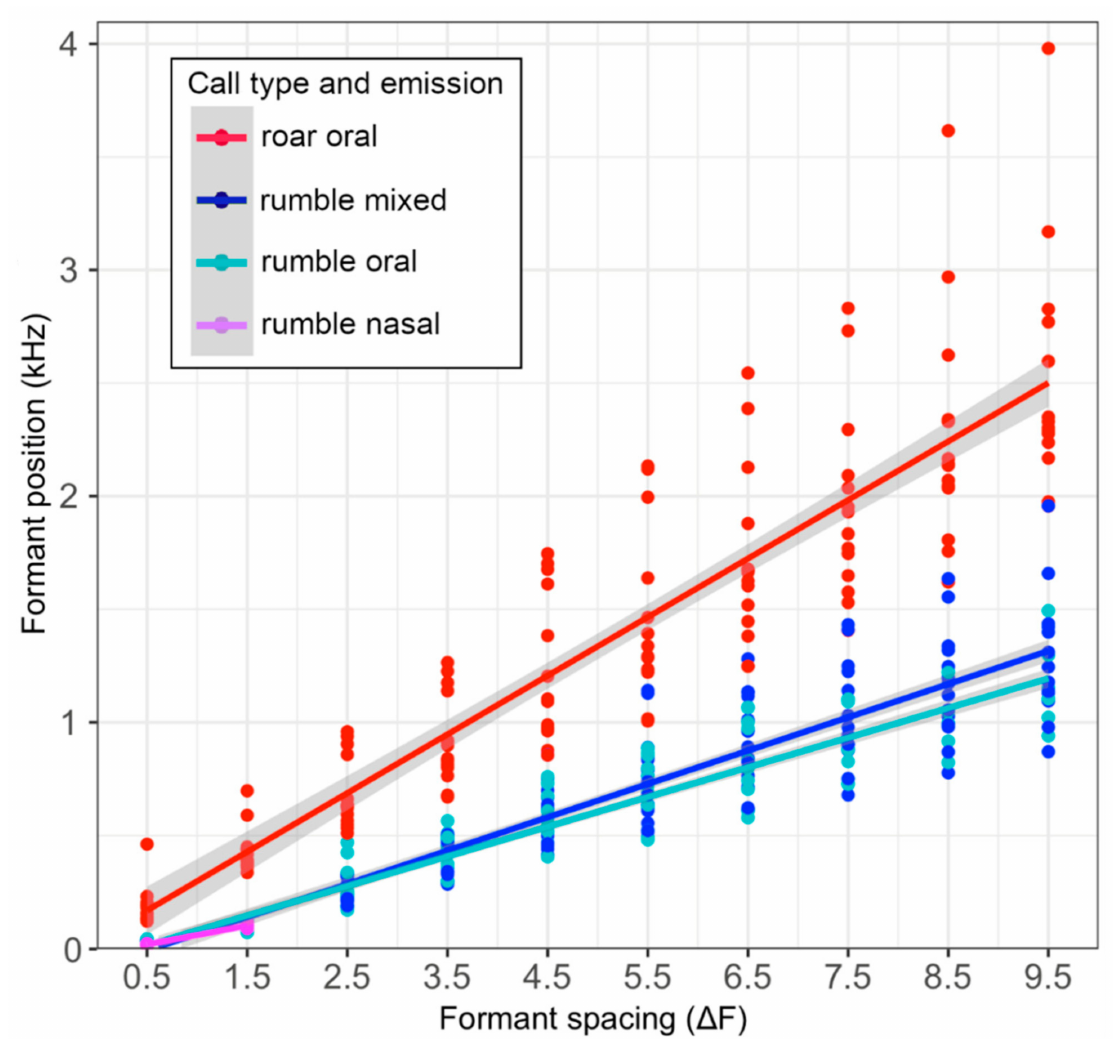
Figure 4. Formant position values in Hz per call and emission type plotted against the formant increment. The regression line gives the values for the formant spacing ( ∆ F1–F10) that is used to calculate the vocal tract length. Formant position values varied more among calls in higher